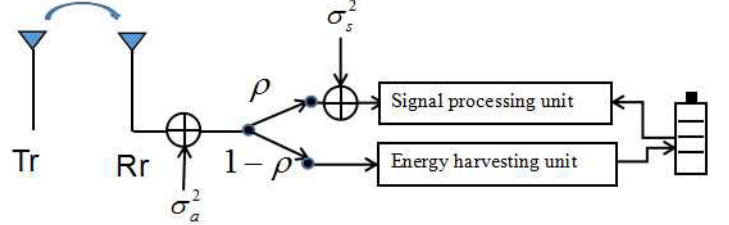
Figure 2. A practical transceiver design with power splitting mode.